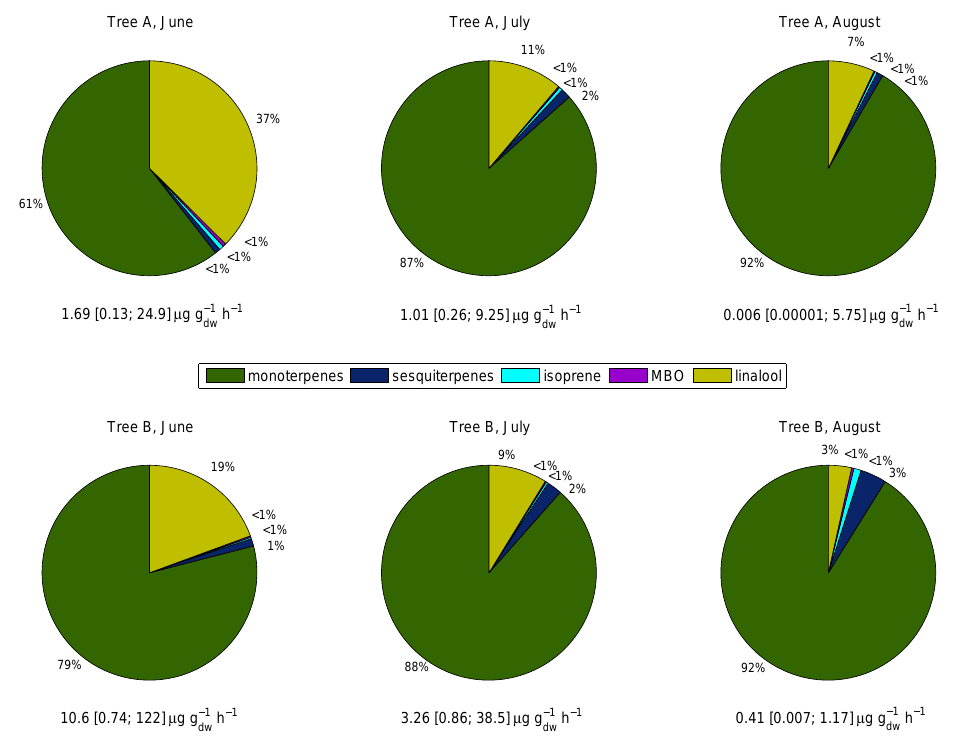
Fig. 2. Measured emission spectra of VOCs from the two Larix cajanderi trees during the measurement campaigns. Given below each pie chart are the monthly median and 5th and 95th percentile values of the total terpenoid emission